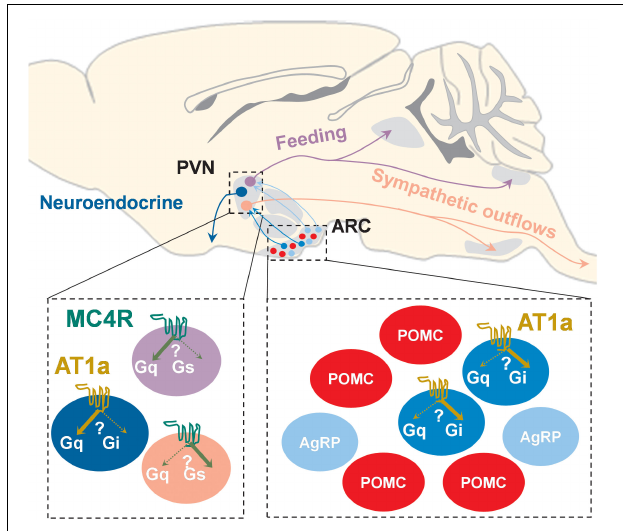
FIGURE 2 | Schematic of possible brain circuit- and cell type-specific MC4R and AT1a signaling pathways in both PVN and ARC. PVN MC4R + neurons project to different brain regions to differentially regulate feeding and sympathetic outflows, and it is possible that MC4Rs in these functionally and neuroanatomically distinct neurons may preferentially activate one involved downstream signaling cascade (G α s and/or G α q ) over another. AT1a is uniquely expressed in a subset of ARC AgRP + neurons as well as PVN neuroendocrine neurons, and it has been suggested that AT1a in these neurochemically defined neurons may preferentially coupled to either G α q (PVN) or G α i (ARC AgRP +